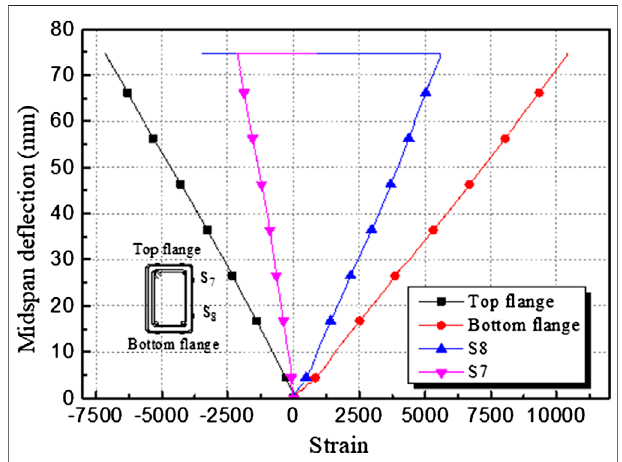
FIGURE 10 | Strain-midspan de fl ection curves (specimen